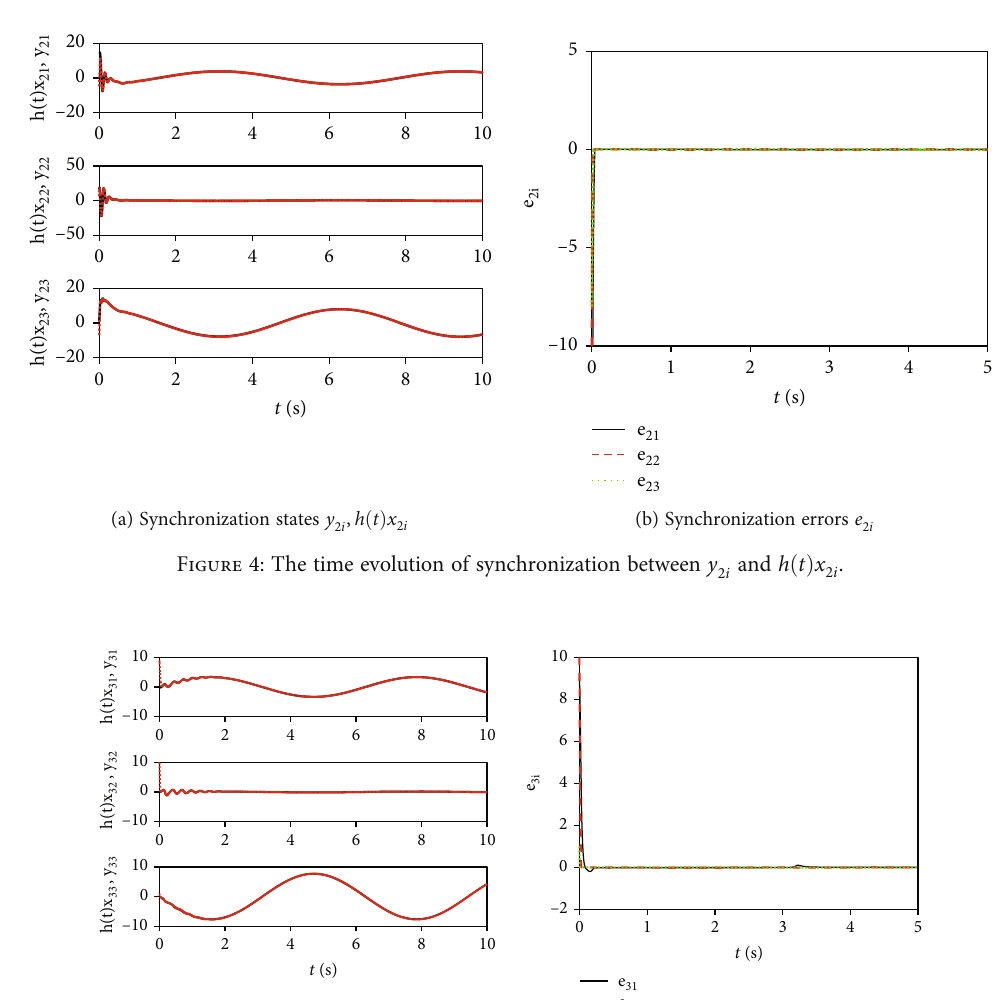
and h ð t Þ x . 1 i 1 i